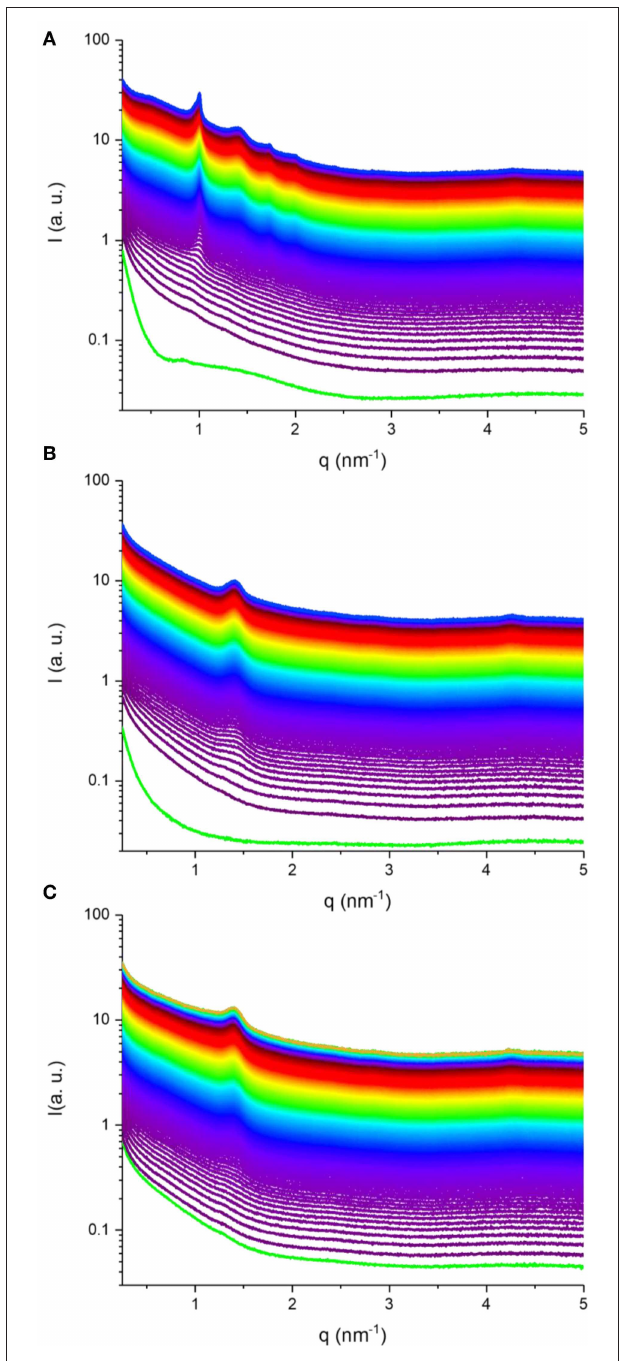
FIGURE 3 | SAXS patterns for three in situ digested KO emulsion (A) , and AO emulsions stabilized by using sodium caseinate (B) and citrem (C) . In (A–C) , the time-resolved SAXS experiments for about 49, 50, and 57min, respectively, were conducted on the three investigated KO and AO emulsions (samples S1–S3, see Table 2 ) at 37 ◦ C. The green SAXS patterns in (A,B) are taken for the two KO (A) and AO (B) emulsions stabilized by using sodium caseinate emulsions before the addition of pancreatin extract containing the lipase. For the in situ SAXS experiments, the first SAXS pattern was plotted 20s after addition of the pancreatin extract, and then SAXS patterns were plotted every 10s during the lipolysis